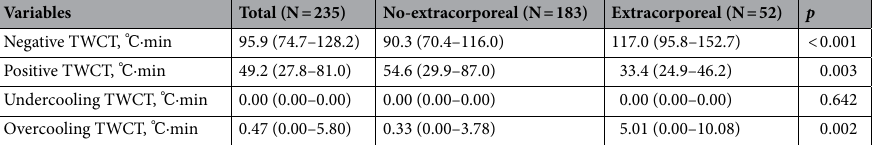
Table 2. Time-weighted core temperatures in the extracorporeal groups. Values are expressed as medians with the interquartile range. TWCT time-weighted core temperature.